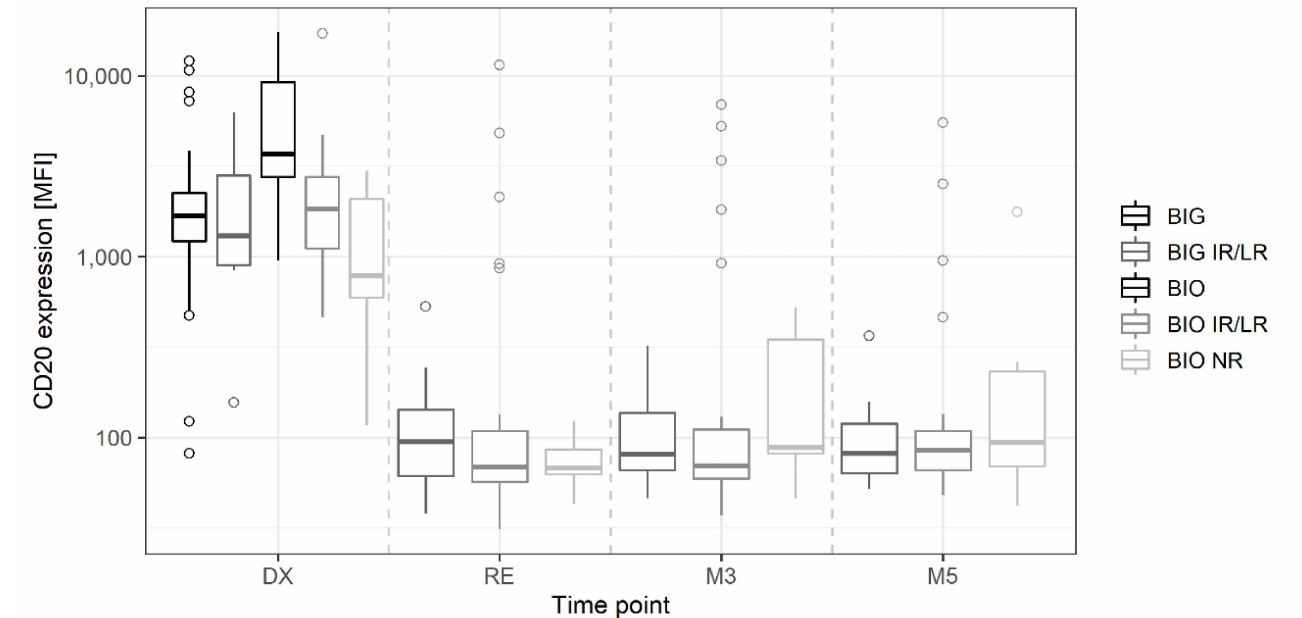
Figure 7. Expression of CD20 (MFI) on CLL cells in diagnostic (DX) and on-therapy samples (final restaging: RE; maintenance cycle 3 or 5: M3, M5) for patients in the CLL2-BIO and CLL2-BIG trials, scored according to their MRD response. MRD response categories include patients with medium and weak responses according to the therapy scheme (BIG_IR/LR, BIO_IR/LR), the non-responders in the BIO trial (BIO_NR), and patients with uMRD response (BIG,